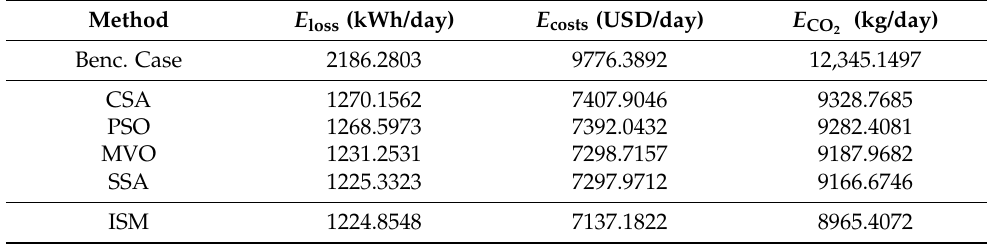
Table 3. Comparative analysis of the combinatorial methods with the proposed